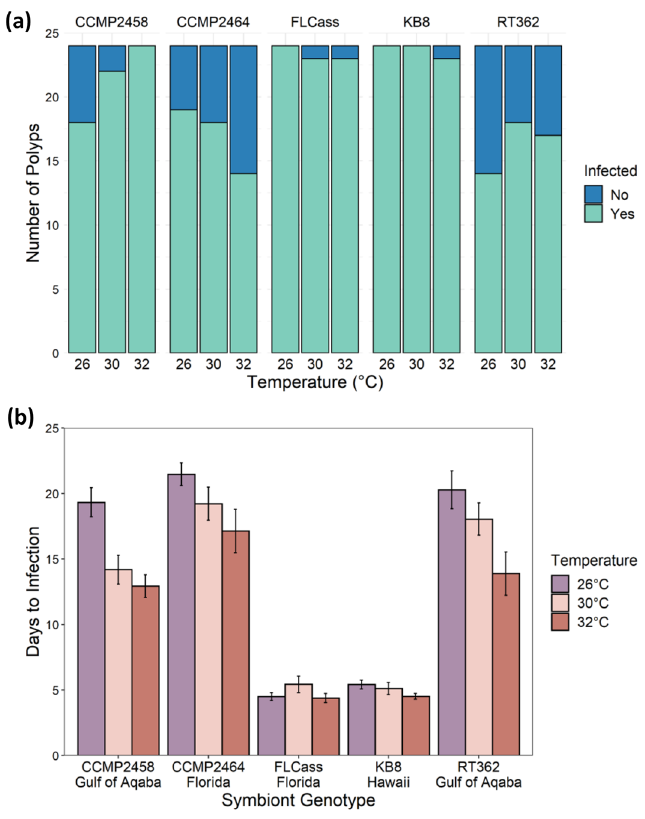
Figure 4. ( a ) Number of polyps that were infected with one of five algal genotypes at each temperature by the end of the experiment. ( b ) Mean (+ SE) days that it took for polyps to become infected with one of five algal genotypes across the three experimental